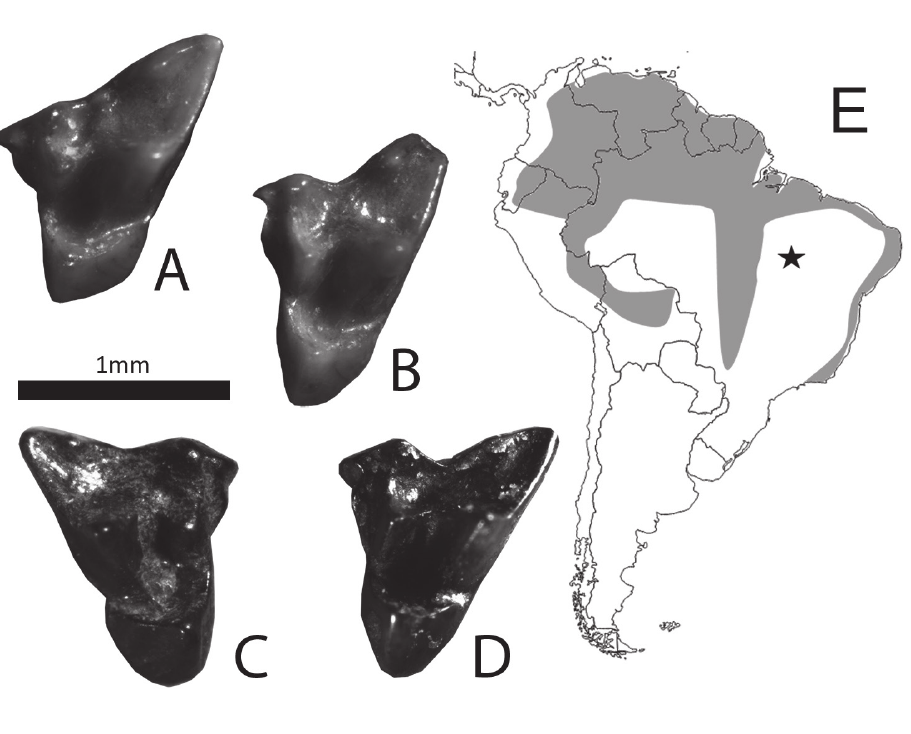
Figure 4 - Selected specimens of Marmosa murina from Gruta dos Moura and its revised geographic distribution for the Pleistocene. A. Left M1 (UNIRIO-PM1093) in occlusal view; B. Left M2 (UNIRIO- PM1093) in occlusal view; C. Right M3 (UNIRIO-PM1222) in occlusal view; D. Left M2 (UNIRIO- PM1224) in occlusal view. Scale 1mm. E. Geographic Distribution of Marmosa murina . Gray area is its extant geographic distribution. Black star marks the Gruta dos Moura cave locality. (Gardner 2008, Winge 1893, Salles et al. 1999, Cartelle